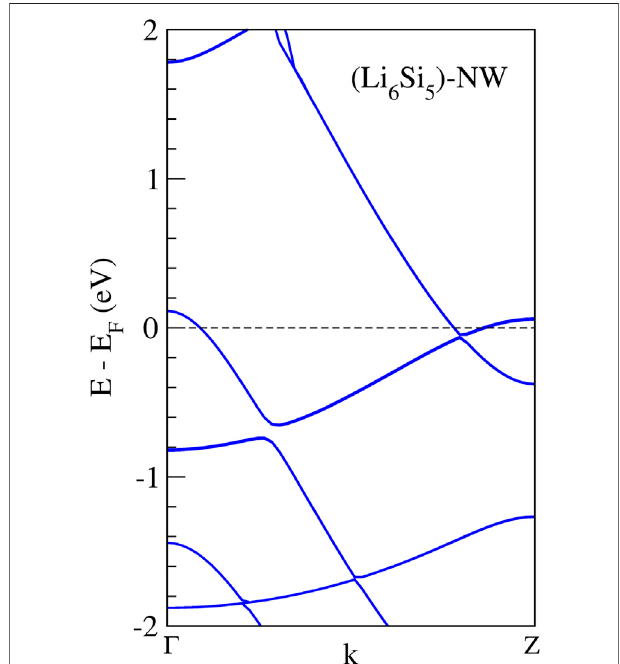
FIGURE 3 | Band structures calculation of the Li 6 Si 5 -NW in the unit cell. The dashed line indicates the Fermi energy.